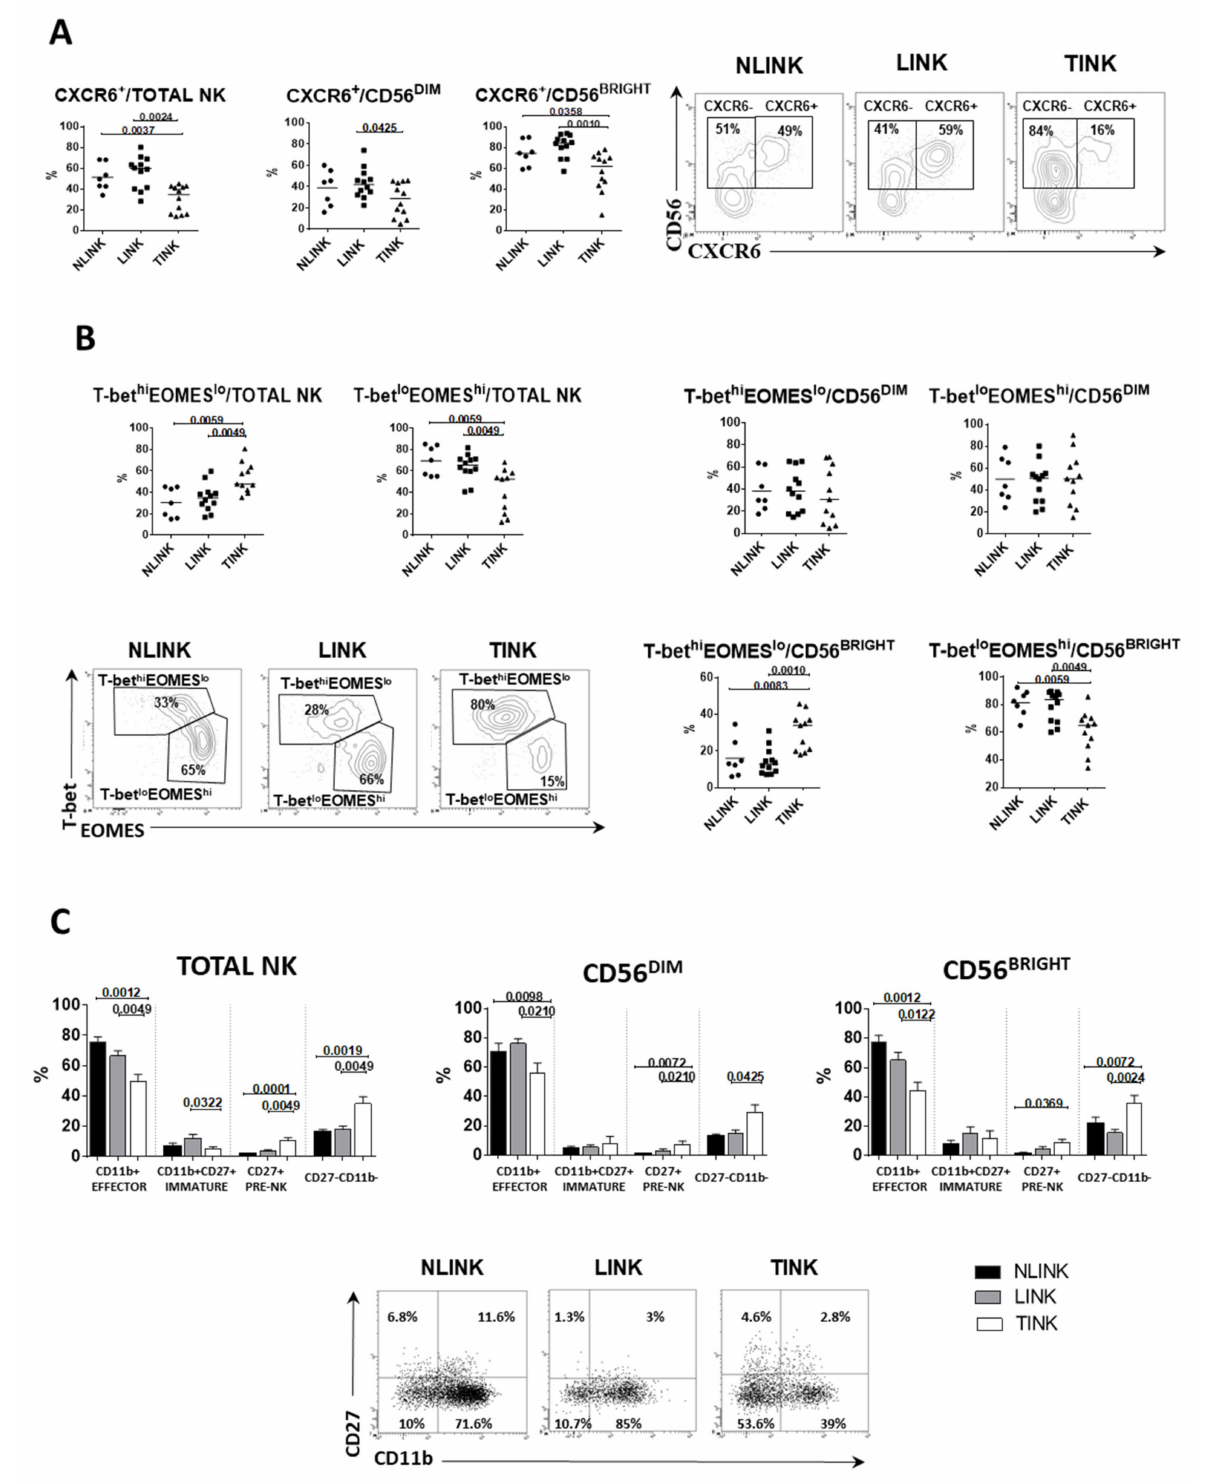
Figure 2. Frequency and residency phenotypes of NK cells infiltrating normal liver tissue (NLINK, n. 7), HCC-surrounding liver (LINK, n. 12), and HCC (TINK, n. 12). ( A ). Left: percentage of CXCR6+ NK cells in NK cell subsets from NLINK, LINK, and TINK. Right: representative dot plots of CXCR6 staining. ( B ). Frequency of NK cells expressing different levels of T-bet and Eomes in total, CD56 DIM , and CD56 BRIGHT NK cells. Dot plots represent T-bet and Eomes staining. ( C ). Percentages of NK cells expressing different levels of CD11b and CD27. Lower panels: dot plots of CD11b and CD27 staining. Horizontal lines represent median values; bar graphs show mean ± SEM. Statistics by Wilcoxon matched pairs test (LINK vs. TINK) and Mann–Whitney test (NLINK vs. LINK and NLINK vs.